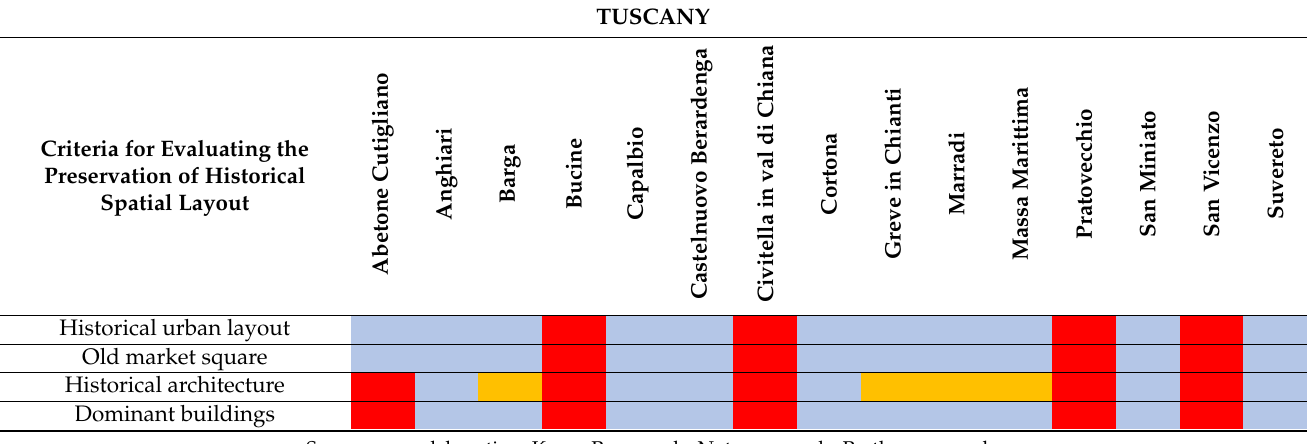
Table 13. Preservation of historical spatial components in Tuscan towns. TUSCANY